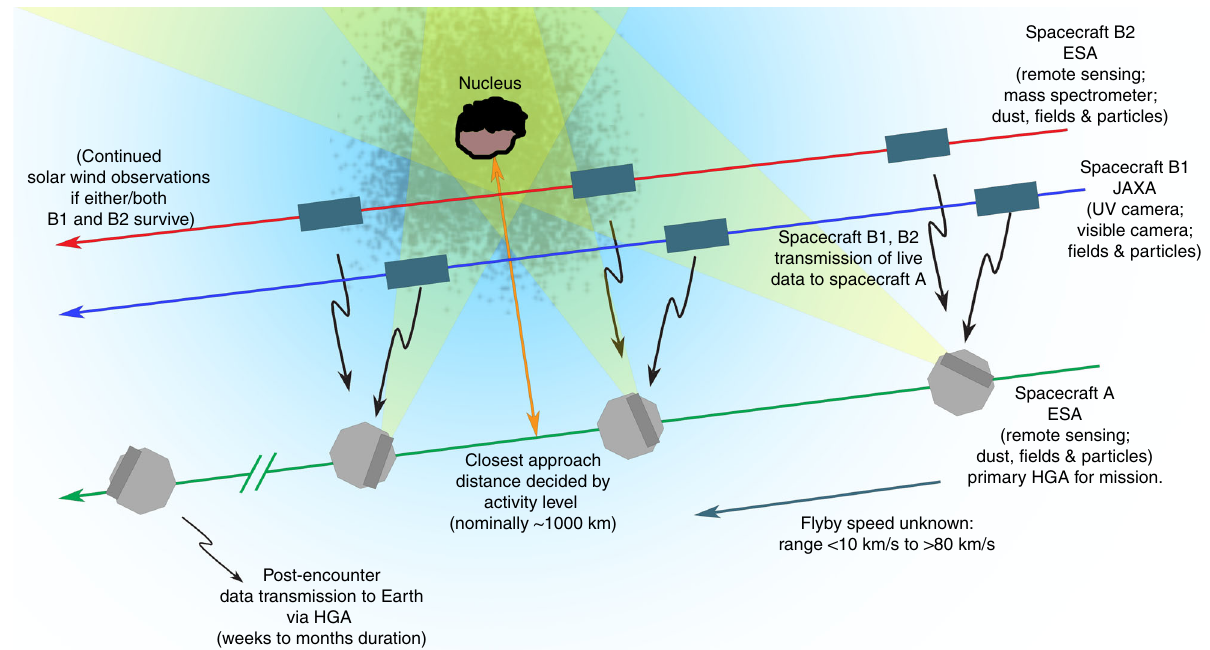
Fig. 2 The proposed general encounter sequence for Comet Interceptor, not to scale. Green, blue and red lines are the trajectories of spacecraft (SC) A, B1 and B2, respectively. SC A passes farthest from the nucleus, performing remote sensing observations and receiving data from SC B1 and B2, which follow near-parallel trajectories nearer the nucleus. Post-encounter, SC A transmits stored data from all three platforms to Earth. The fi nal SC, payload and precise fl yby scenario may change as the mission development